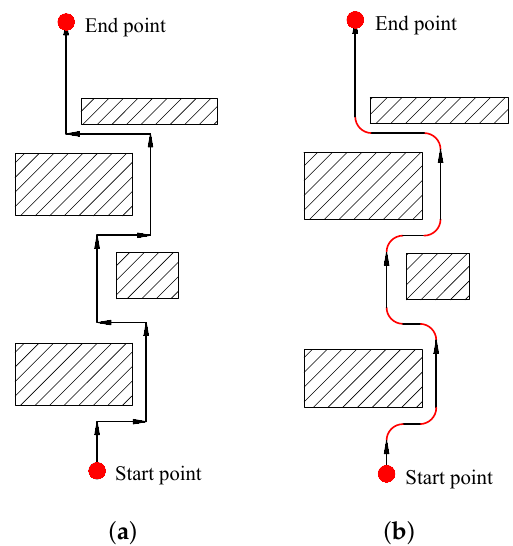
Figure 1. Original path and smooth path profiles: ( a ) Original path. ( b ) Smooth